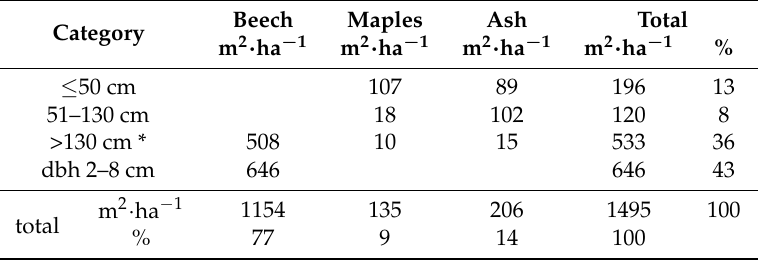
Table 5. Area of spatially continuous natural regeneration according to dominant tree species and height/dbh category.